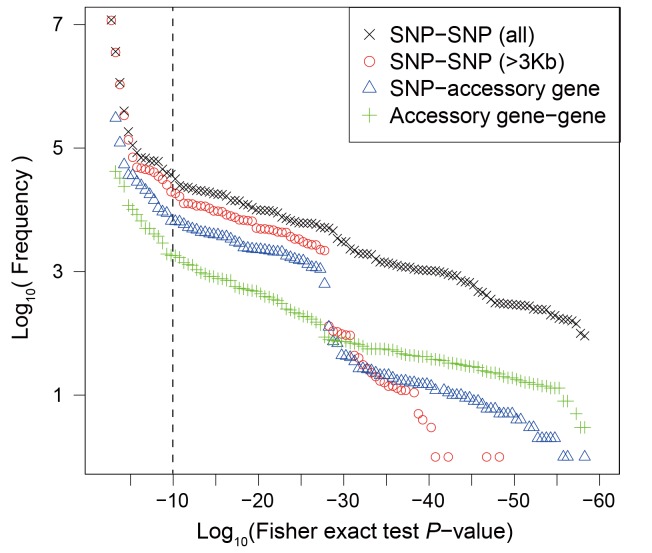
Frequency distribution of Fisher exact test P values between genetic variants.Colors and shapes indicate the interactions between different types of variants. The vertical dotted line shows the threshold p=10−10.